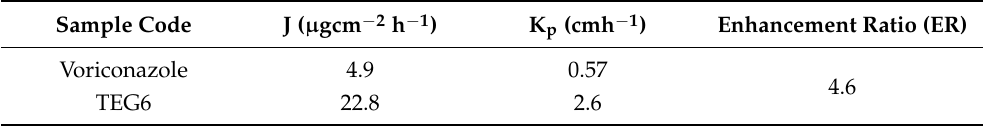
Table 3. The permeation flux (Jmax) at 12 h and the enhancement ratio (ER) of pure VRC and TEG6